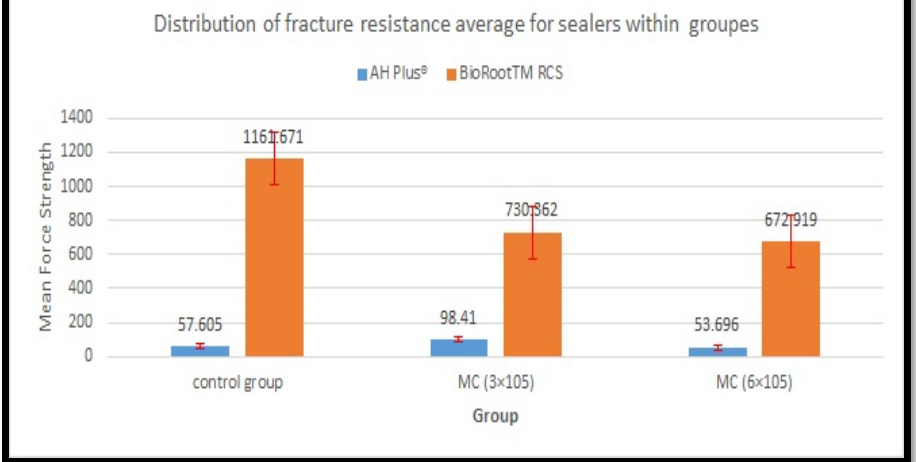
Figure 5. Mean force strength (N) of sealers at di ff erent time intervals.